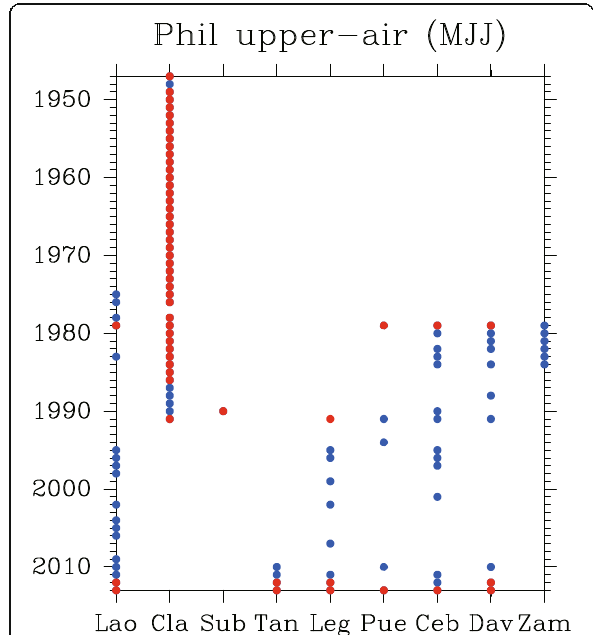
Fig. 2 Availability of upper-air observations. More than half of the period of May to July, upper-air observation is conducted at 00Z or at both 00Z and 12Z — i.e., once or twice a day, are colored in blue and red respectively. The measurement stations Laoag (Lao), Clark air base (Cla), Subic (Sub), Tanay (Tan), Legaspi (Leg), Puerto Princesa (Pue), Cebu (Ceb), Davao (Dav), and Zamboanga (Zam) are shown along the